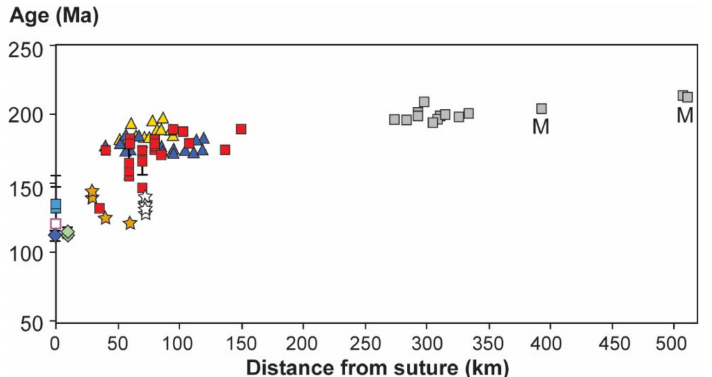
Figure 4. A comparison of crystallisation age (mainly zircon 238 U- 206 Pb concordia ages) and present- day longitudinal distance from the palaeotrench, which is defined as the Ingapirca-Peltetec fault in Ecuador, and the Silvia-Pijao fault in Colombia. Symbols are the same as in Figure 3. M: M é rida